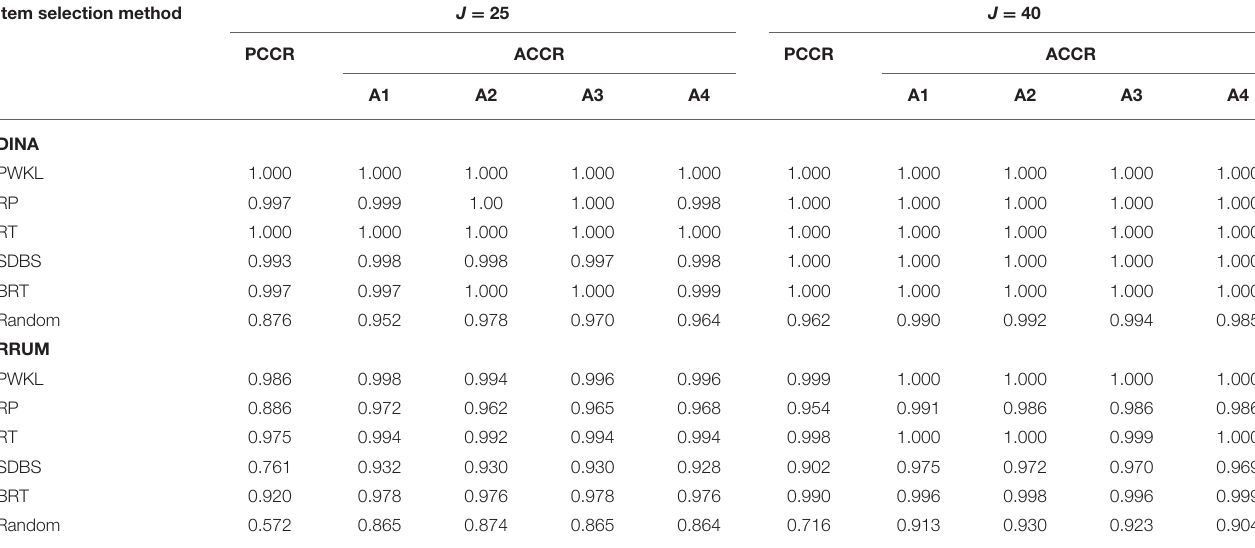
TABLE 1 | The correct classification for four attributes. Item selection method